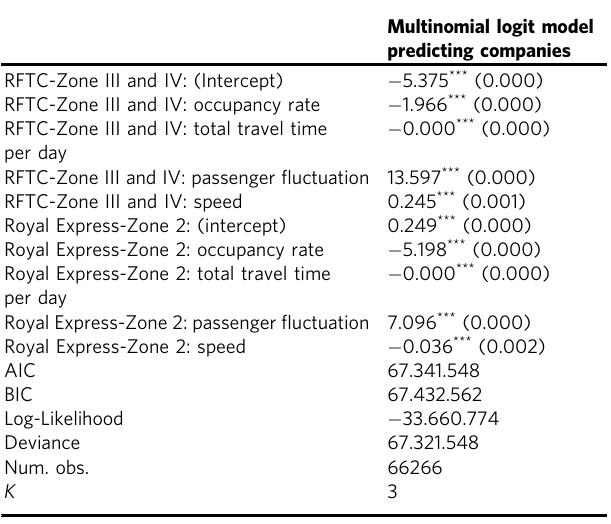
Table 1 Multinomial logistic regression predicting companies.